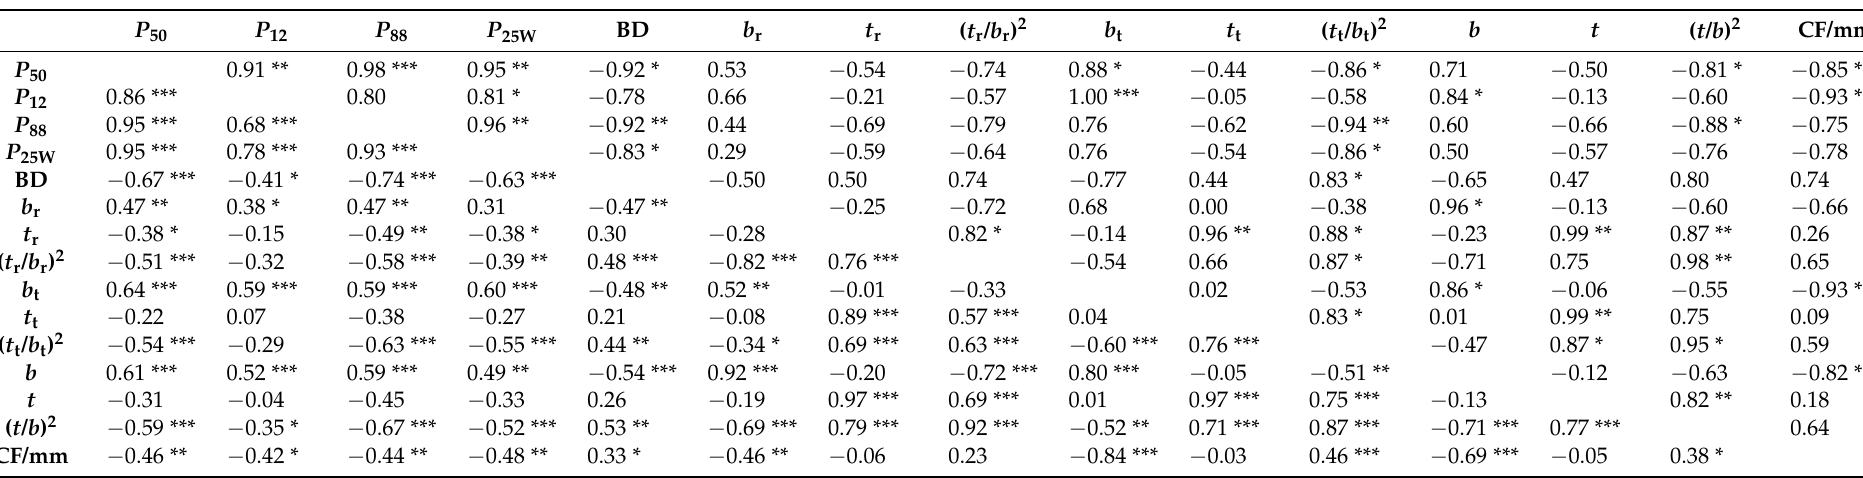
Table 4. Correlation matrix for hydraulic and wood anatomical traits. Numbers in the upper right are the Pearson correlation coefficients of species mean values ( n = 6), numbers in the lower left of the sample values (vulnerability curves, n = 34). The significance level is indicated with “*” if p < 0.05, “**” if p ≤ 0.01 and “***” if p ≤